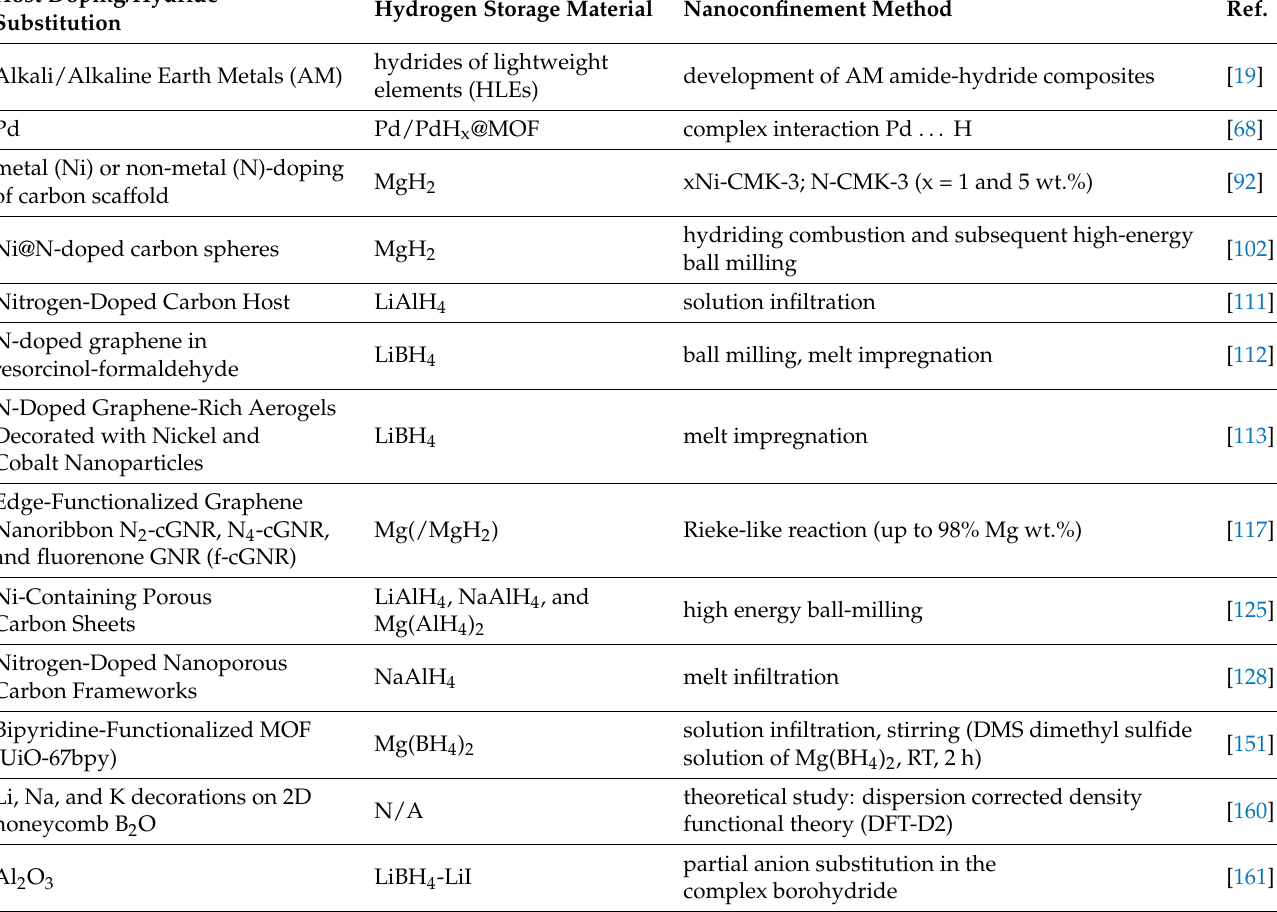
Table 8. Examples of host decoration/doping and hydride substitution in nanosized